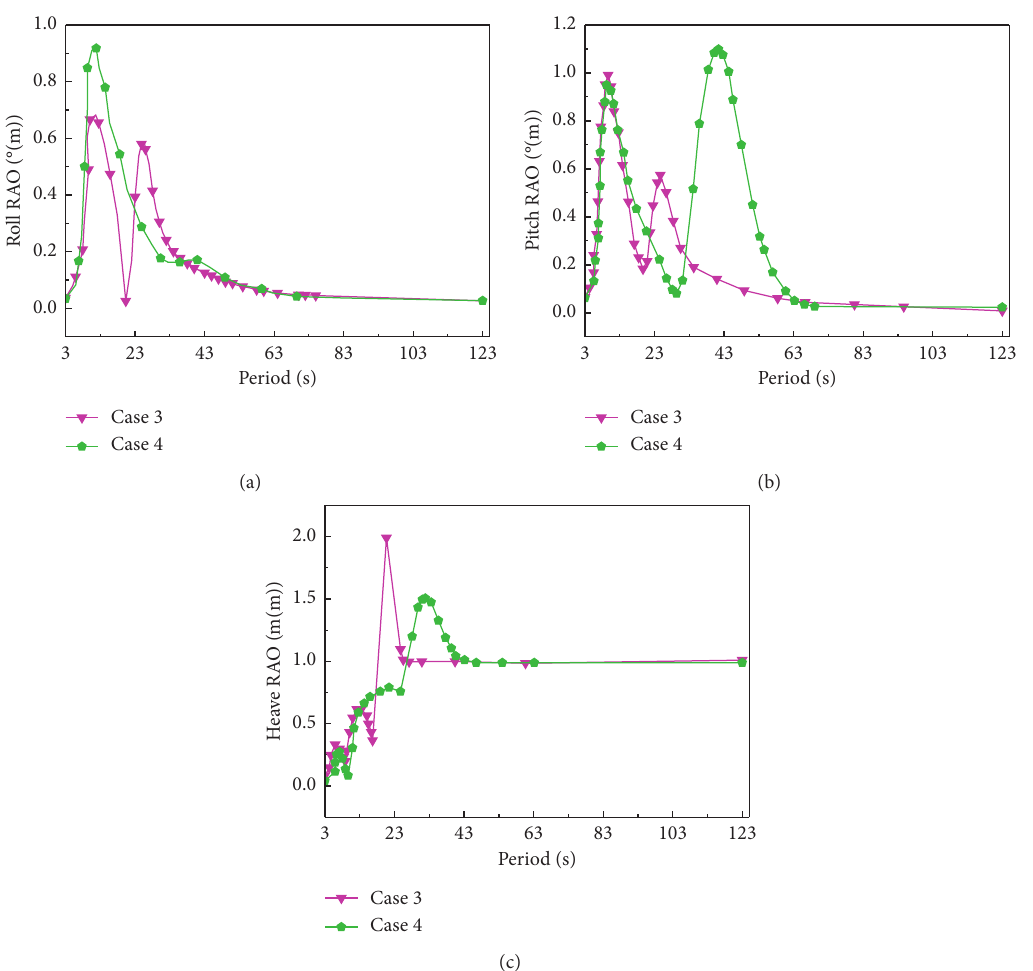
Figure 16: The motion response of the platform with different column cross sections. (a) Roll, (b) pitch, and (c)